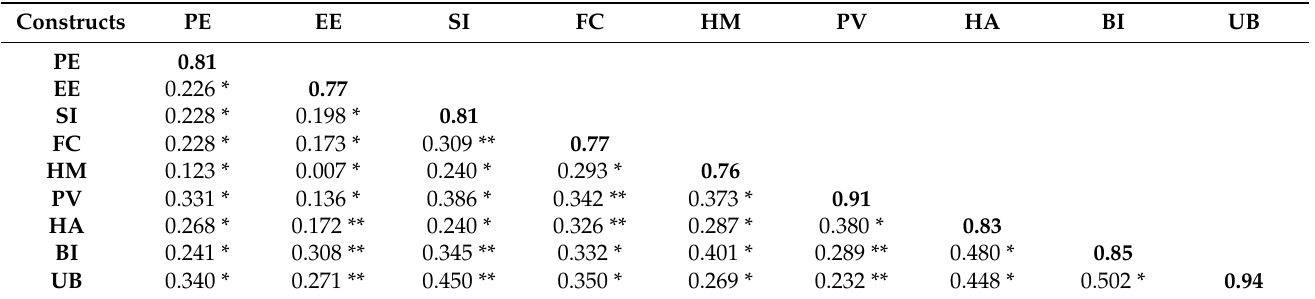
Table 3. Inter-Construct Correlations.